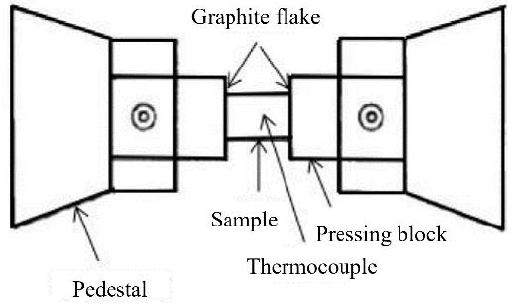
Figure 1. Clamping diagram of the hot compression test sample. In the hot compression experiment, lubricants and graphite plates are used to minimize the influence of friction, but the influence of friction on the deformation of the sample cannot be eliminated in the actual compression process. The friction force causes the sample to deform unevenly during hot compression, and the cylindrical sample is usually a drum-shaped cylinder with a larger diameter after hot compression, as shown in Figure 2.